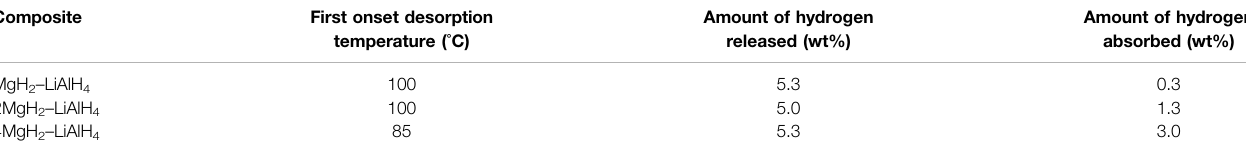
TABLE2| TGAresultsshowthetemperatureofdesorptionandtheamountofhydrogenabsorption/desorptionfromMgH 2 – LiAlH 4 withdifferentamountsofcomposites(Lin & Tsai, 2017). Composite